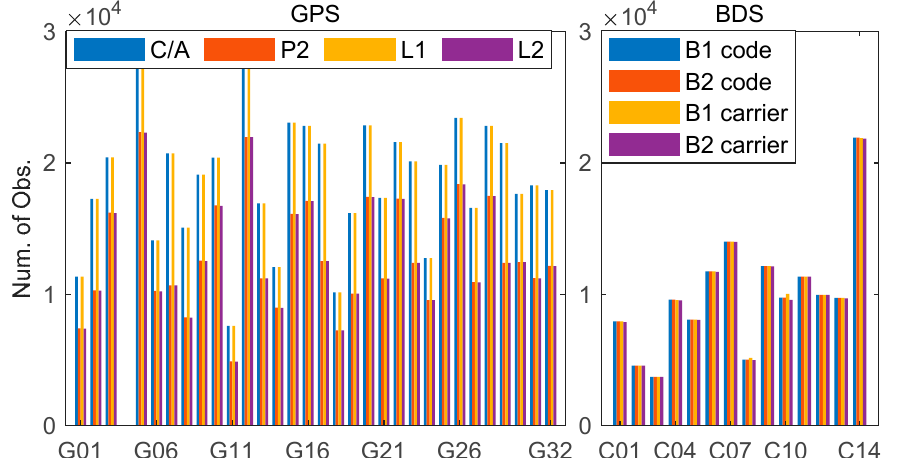
Figure 3. Number of GPS and BDS observations on DOY 202, 2018. The left panel shows the number of GPS C/A, P2, L1 and L2 observations. The right panel shows BDS B1 code, B2 code, B1 carrier and B2 carrier phase observations.